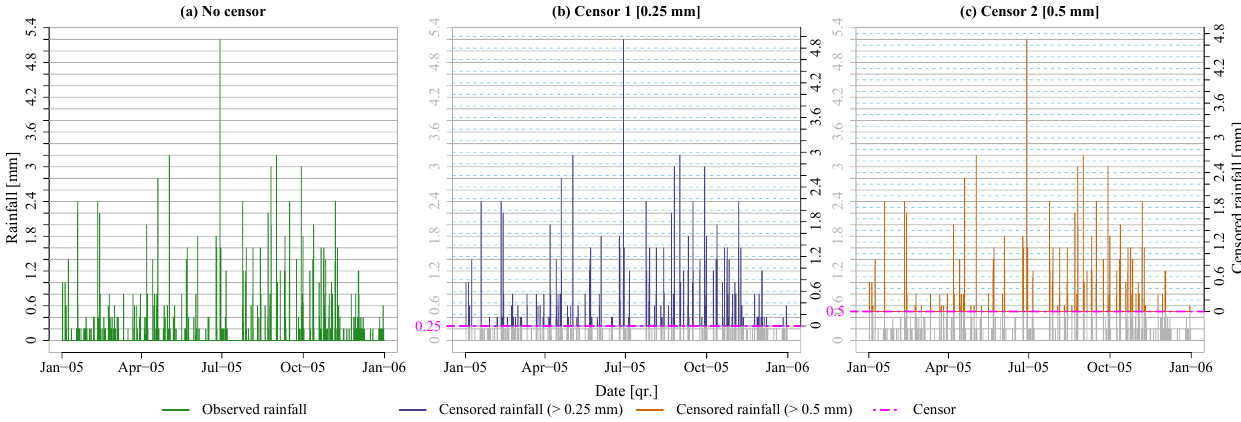
Figure 1. Example censoring applied to 15min rainfall data at Atherstone in 2005. Arbitrary censors of 0.25 and 0.5mm are applied to demonstrate the effect of censoring on the rainfall